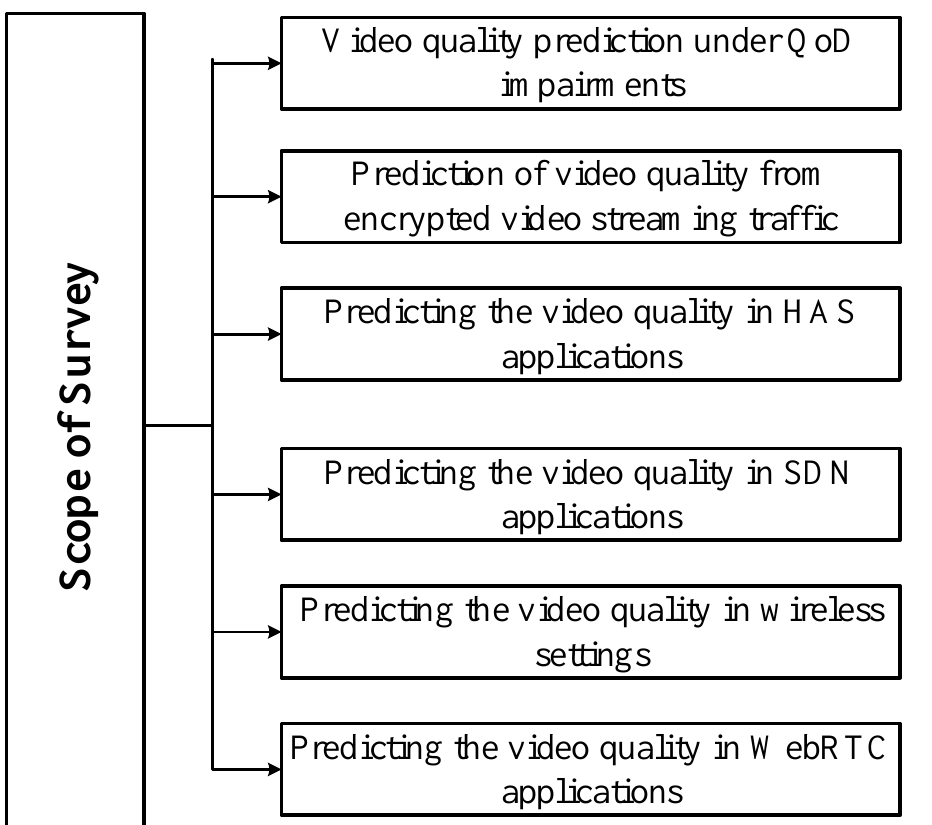
Figure 2. This survey reviews ML video quality prediction using QoD metrics under QoD impairments, encrypted video traffic, HAS video applications, SDN, wireless settings, and WebRTC